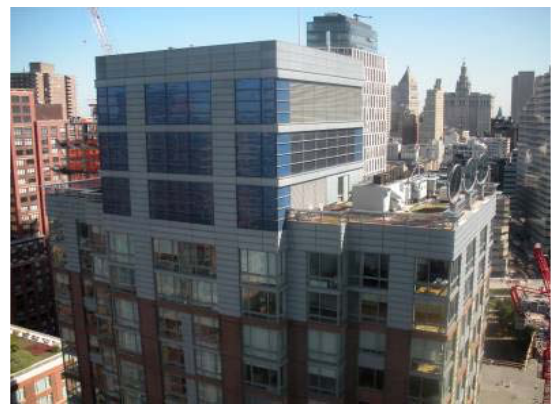
Figure 4. The Verdesian’s bulkhead